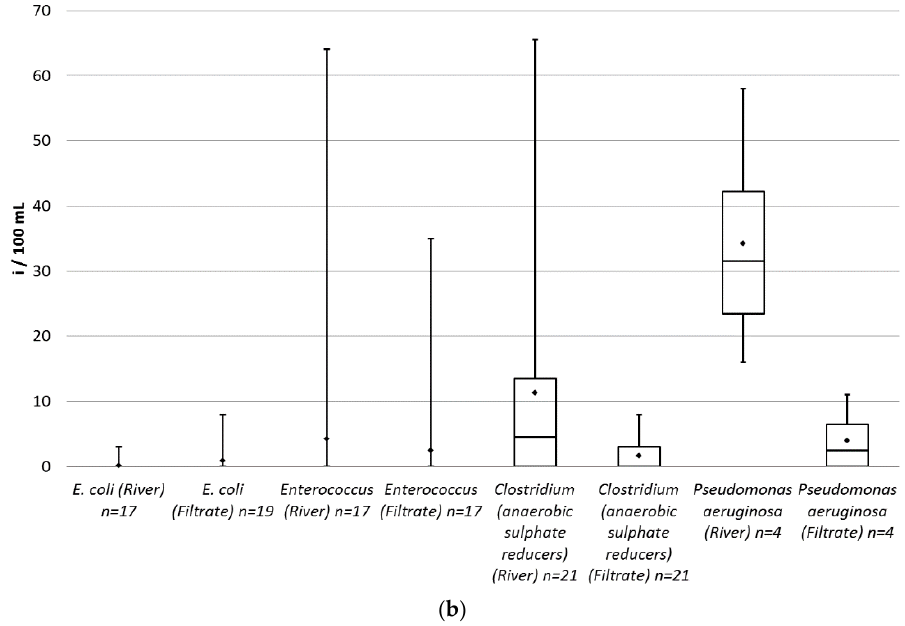
Figure 6. Values of microbiological indicator parameters. CFU = colony forming units, i = individuum. ( a ) Parameters measured as CFU, ( b ) Parameters measured as individual entities.